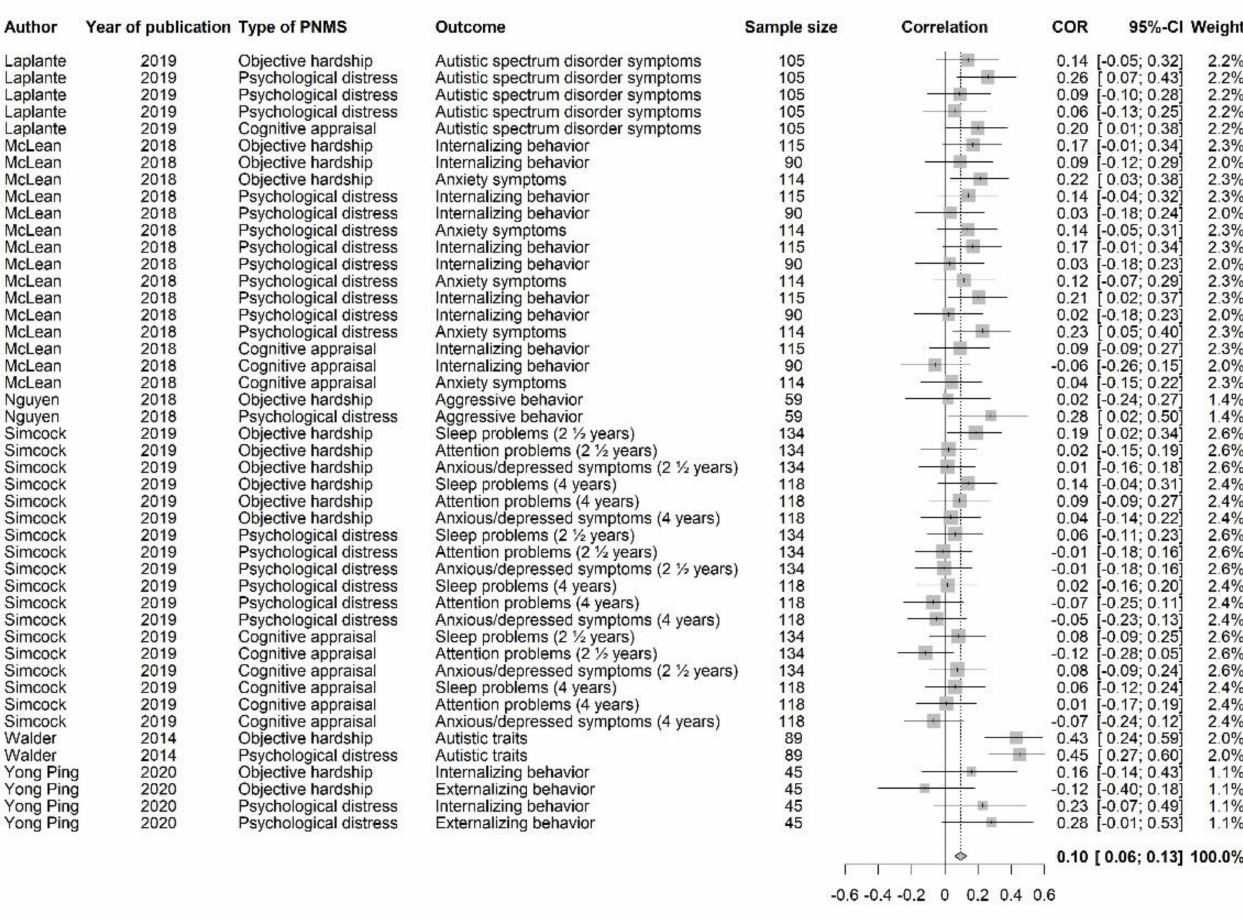
Figure 17. Behavioral outcomes forest plot.